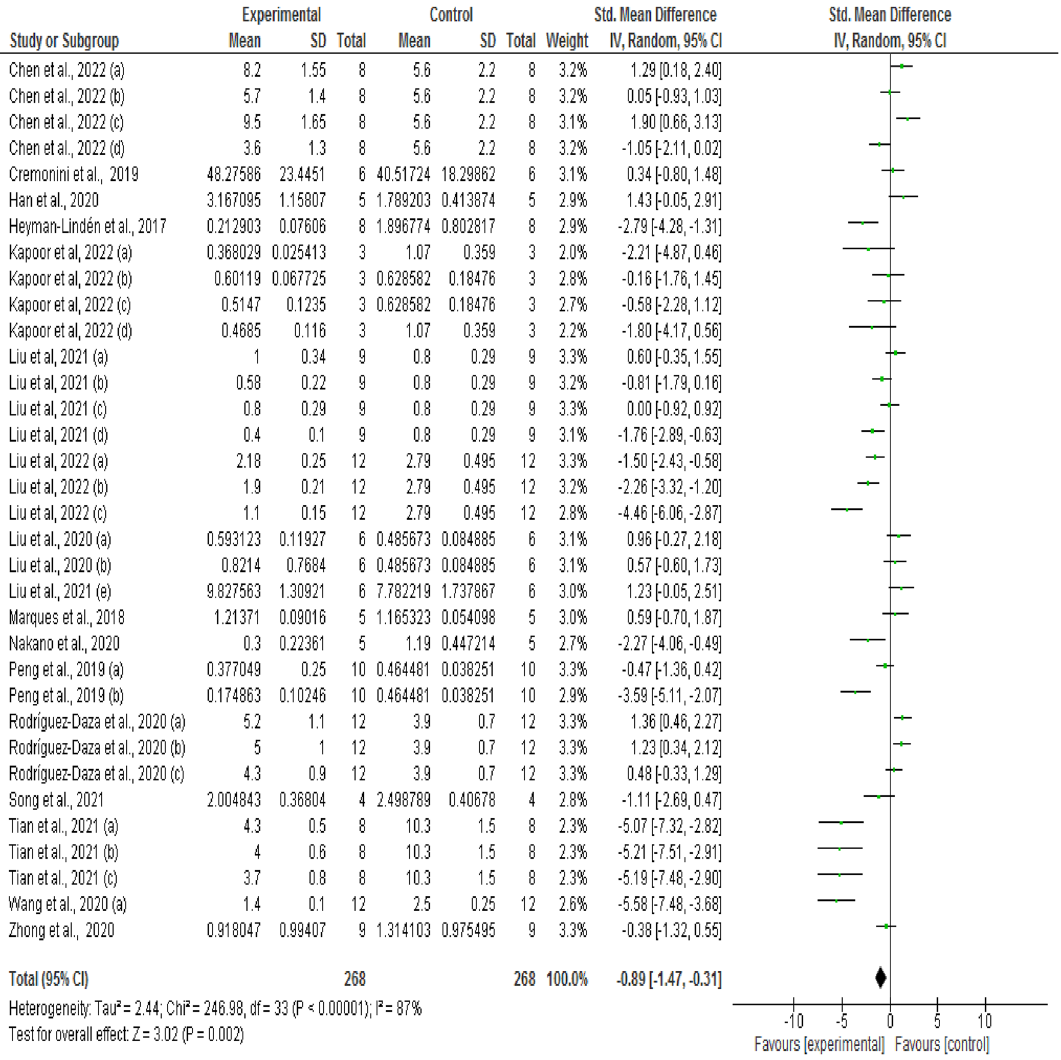
Figure 2. Forest plot of studies investigating the effect of anthocyanin supplementation on the Firmicutes to Bacteroidetes ratio [Fir/Bac]. Pooled effect estimates [diamonds] for Fir/Bac are shown after removing highly influencing studies. Values are standardized mean differences with 95% CIs determined with the use of random- effects models. Heterogeneity was quantified by I 2 , inverse variance and standardised mean difference